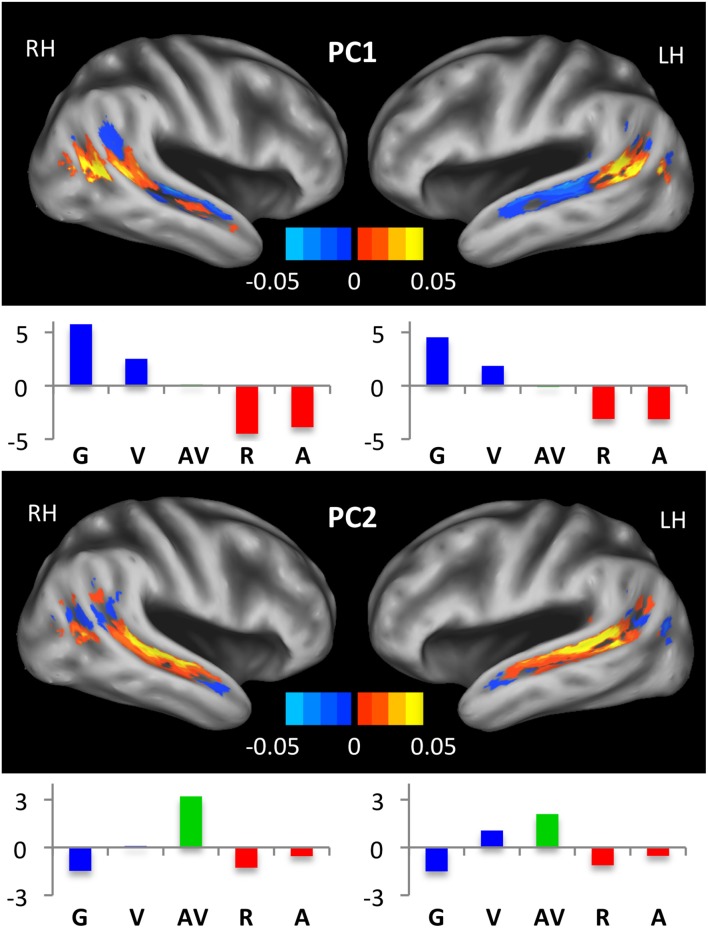
Principal component maps. Condition scores and voxel coefficients for the first two principal components are shown. Principal component analyses were performed separately for left and right STS. Voxel coefficients are displayed on inflated surface renderings of the study-specific template. Color maps indicate the sign and magnitude for voxel coefficients. Condition scores are displayed as bar plots beneath the relevant brain image, with conditions color-coded as in Figures 2, 3, 5. Voxels with large positive (negative) coefficients activated preferentially to conditions with positive (negative) scores. For example, positive voxels for the first principal component responded maximally during the G and V conditions, while negative voxels responded most to R and A.